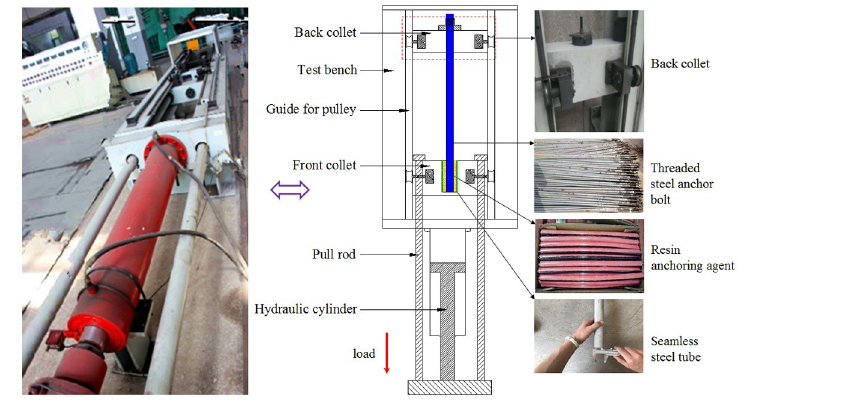
Fig 4. Apparatus for the pull-out test and test materials.